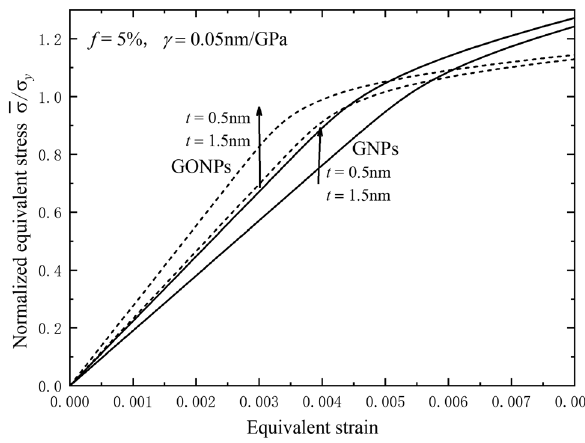
Figure 8: The normalized equivalent stress – strain curves of the nanoplate composite with the di ff erent nanoplate thickness under the same fi ller concentration and the sliding parameter.